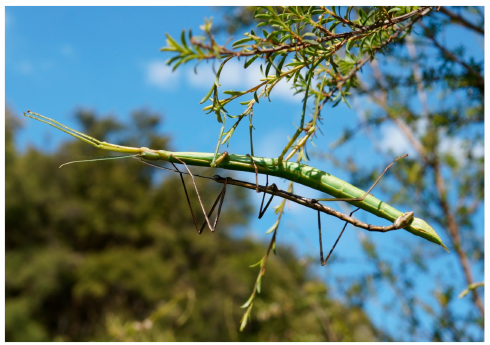
Figure 1. Mate guarding by the New Zealand stick insect Clitarchus hookeri on the host plant, k¯anuka, Kunzea ericoides . Photo credit: Steven